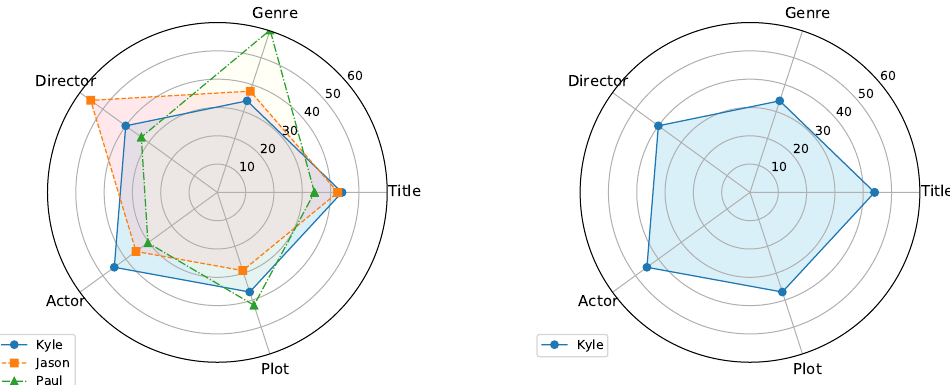
Figure 2. Representing the diagram of priority: In the right diagram, the priority of user Kyle illustrated by a grey area in ordering five features extracted from the movies (title, genre, director, actor, and plot). Combination with other users, in the left diagram, we can see the related of their